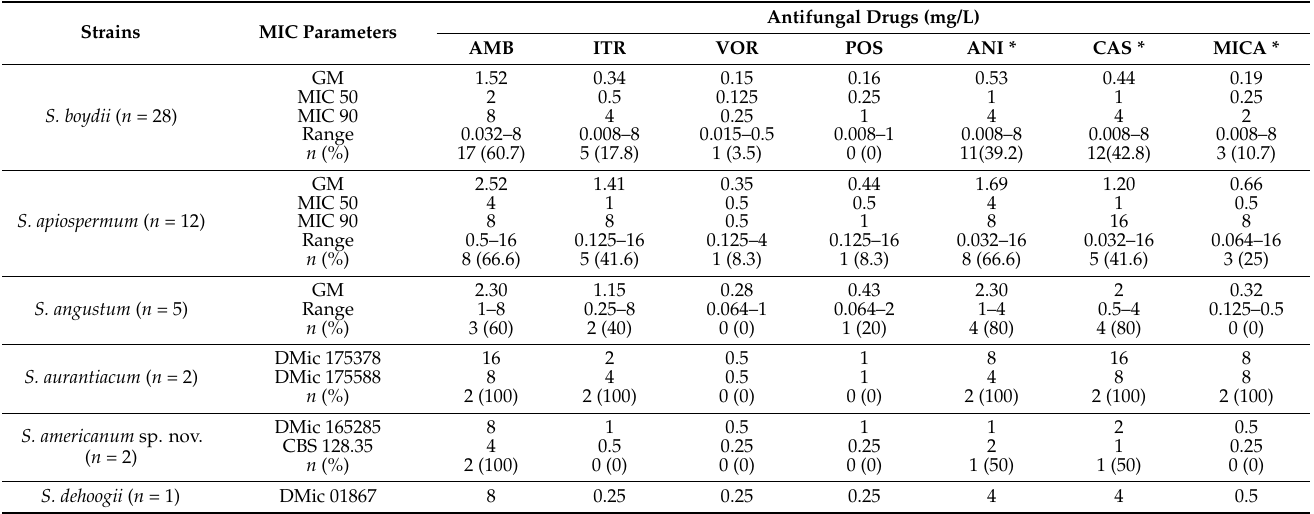
Table 2. MIC and MEC values to seven antifungal drugs against Scedosporium